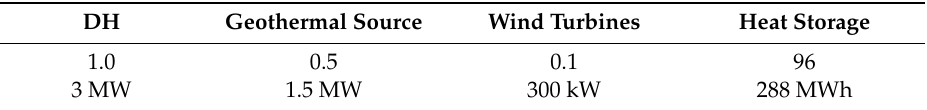
Table A1. An example of how the approach to units was presented in this study including how it should be converted to real case dimensions. For example the maximal heat demand observed in DH was 3 MW. It was represent by “1” in the sizing method. The optimal system configuration was 0.5 in the geothermal source, 0.1 in te wind turbine and the storage capacity was 96 units. When multiplied by “3MW”, the following (third row) parameters were